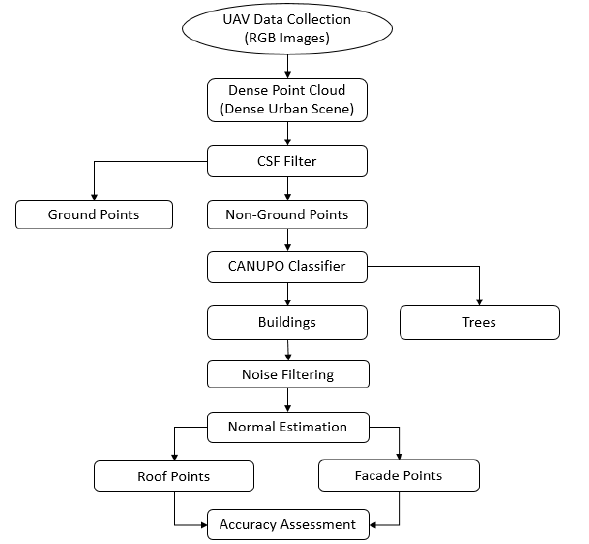
Figure 2: Methodological